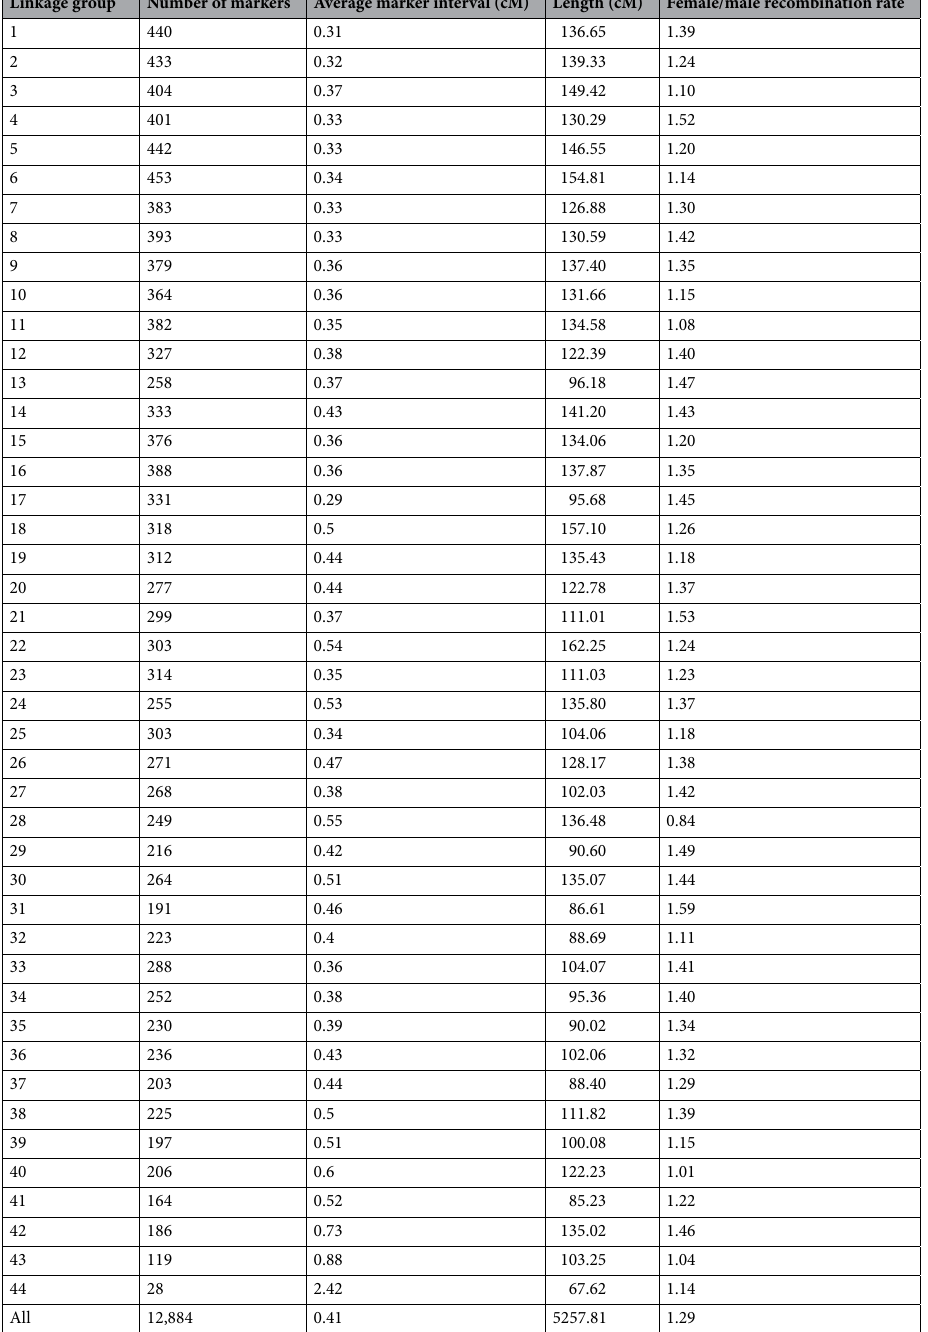
Table 3. Summary of consensus genetic map in F.